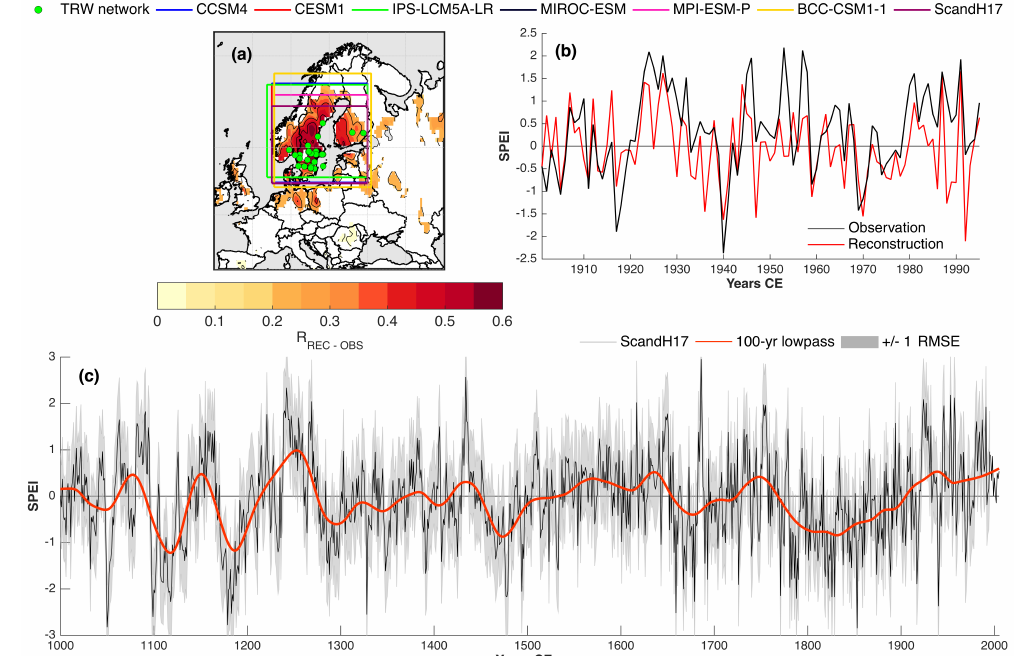
Figure 1. Average regional warm-season SPEI time series reconstructed from tree rings. (a) Location of the tree-ring network used for regional reconstruction and the extent of the CMIP5–PMIP3 model precipitation and temperature grids used to derive regional SPEI esti- mates. Shaded contours display the correlation ( p < 0.1) between the tree-ring reconstruction and fields of instrumental SPEI data over the 1901–1995 period; (b) average regional reconstructed and instrumental 20th century 2-month June SPEI; (c) average regional SPEI nested reconstruction, with the ± 1RMSE of the regression equations outlined in grey shading. A smoothed version of the reconstruction using a 100-year loess smooth is shown in red. Reconstruction assessment metrics are provided in the Supplement (Fig. S4).